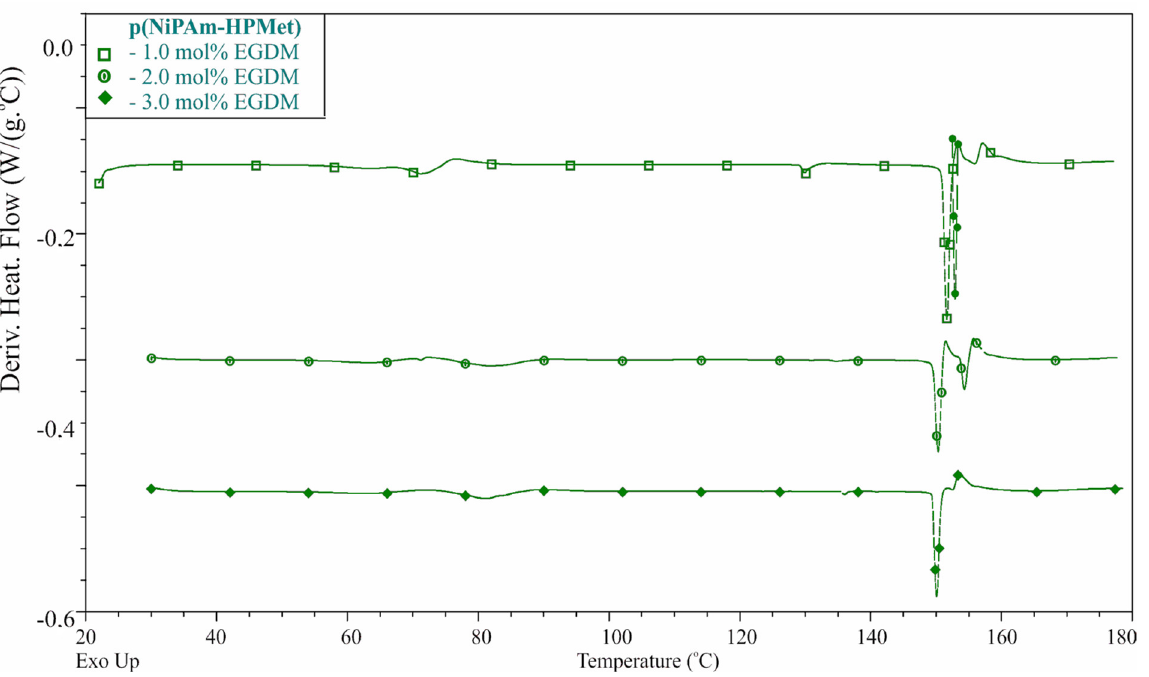
Figure 1. Differential scanning calorimetry (DSC) curves (first derivative of heat flow) of the synthesized poly( N -isopropylacrylamide- co -2-hydroxypropyl methacrylate) xerogels. Values of the temperatures of glass transition ( T g ), melting process ( T m ), and the melting enthalpy for the investigated p(NiPAm-HPMet) xerogels are shown in Table 2. Table 2. The glass transition temperatures ( T g ), melting temperatures ( T m ) and the melting enthalpy ( ∆ H m ) values for the analyzed p(NiPAm-HPMet)